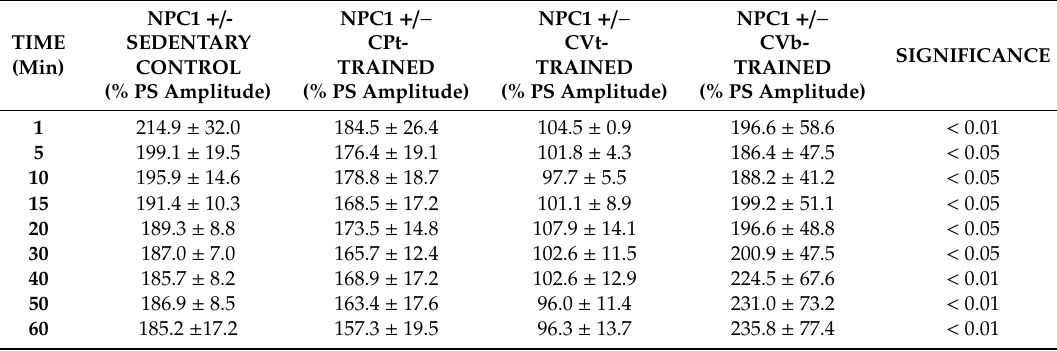
Table 1. Percentage of PS amplitude values recorded in the CA1 region of hippocampal slices from NPC1+/ − mice at different times.